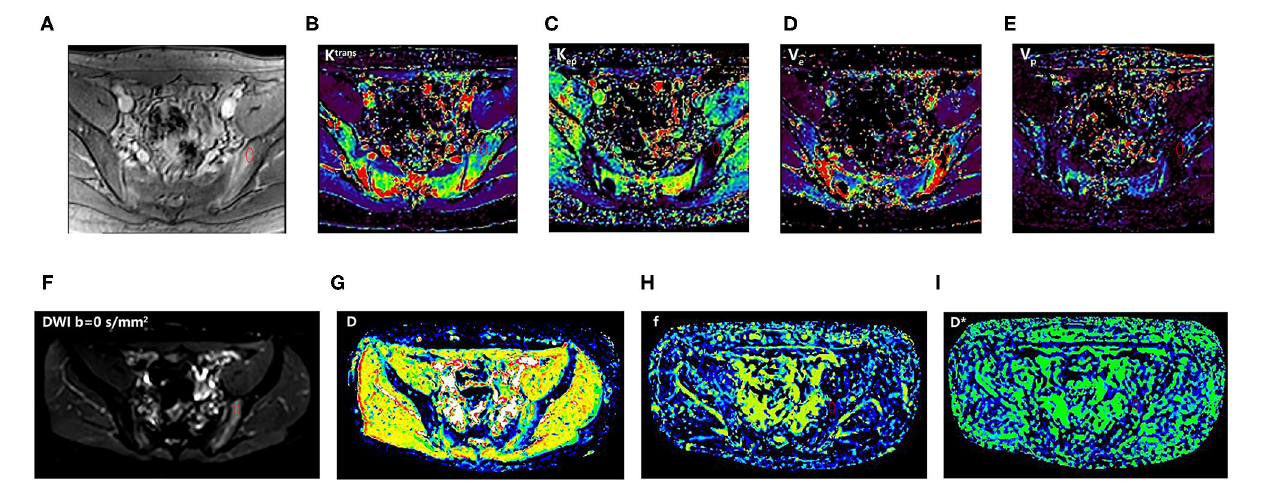
FIGURE 2 | An 18-year-old man with SpA. The first-row images (A–E) : DCE-MRI and corresponding quantitative parameter images ( K trans , K ep , V e , and V p ) showing the position of ROI; the second-row images (F–I) : corresponding DWI ( b = 0 s/mm 2 ) and IVIM-DWI parameter images ( D , f , and D *). SpA, spondyloarthritis; ROI, region of interest; T2W_SPAIR, T2-weighted spectral attenuated inversion recovery; DWI, Diffusion-weighted imaging; IVIM, intravoxel incoherent motion; D , pure diffusion coefficient; f , perfusion fraction; D *, pseudo-perfusion coefficient; DCE-MRI, dynamic contrast-enhanced magnetic resonance imaging; K trans , endothelial transfer constant; K ep , reflux rate; V e , fractional extravascular extracellular space volume; and V p , fractional plasma volume.